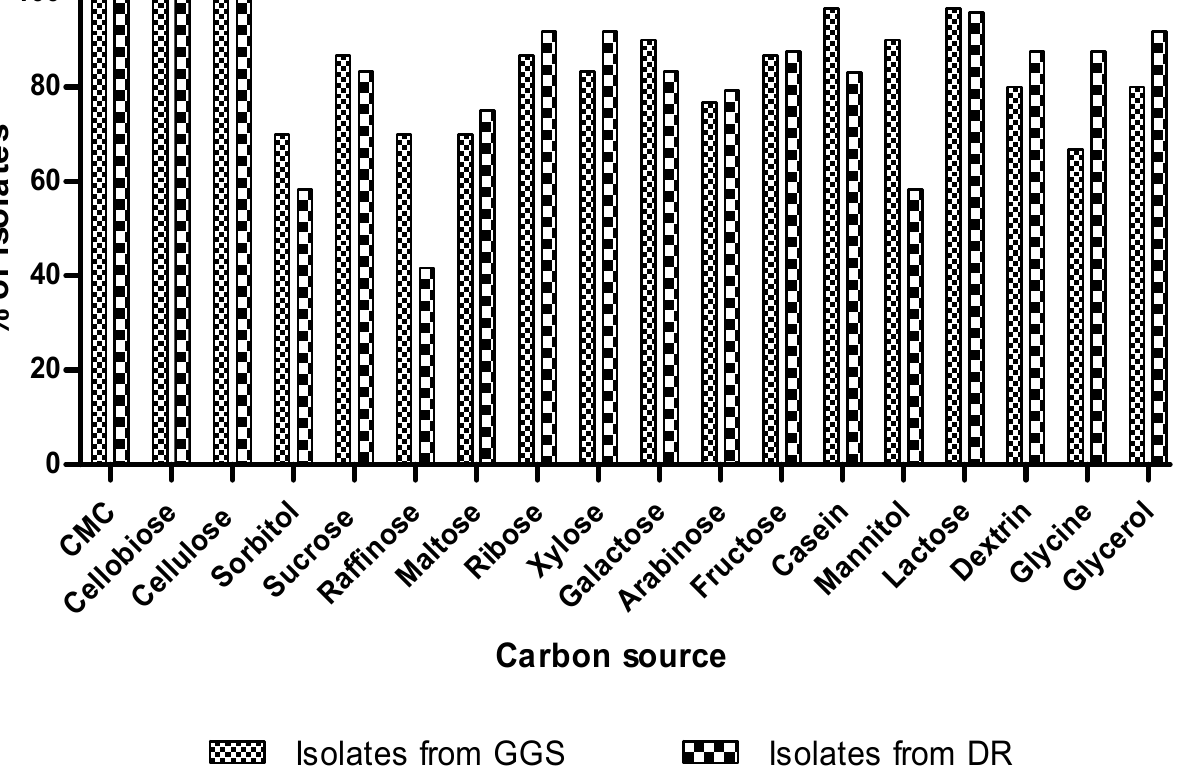
Figure 5. The assimilation of different kinds of carbon sources by yeast strains.